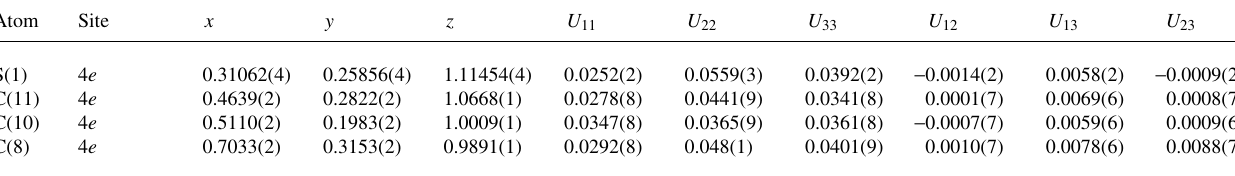
Table 3. Atomic coordinates and displacement parameters (in Å 2 )